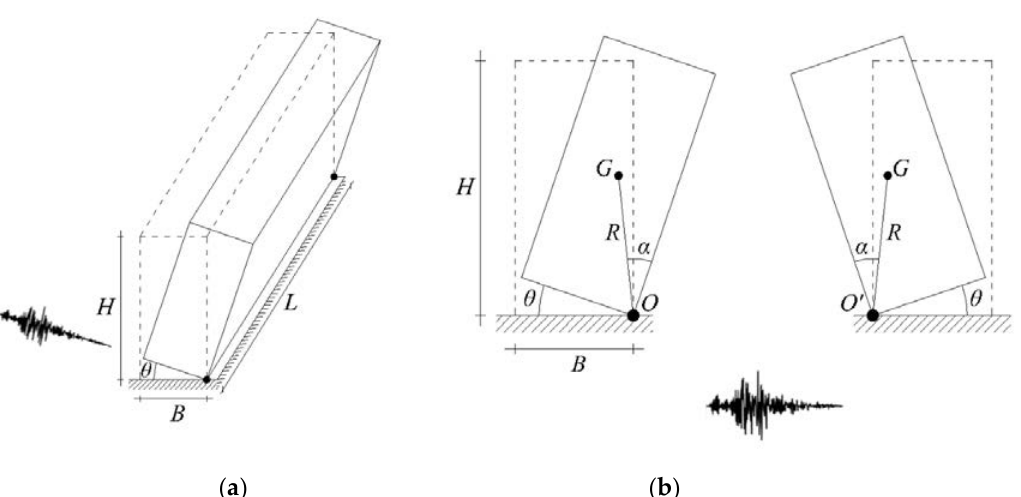
Figure 3. Model of the wall: ( a ) three-dimensional view; ( b ) model geometry.